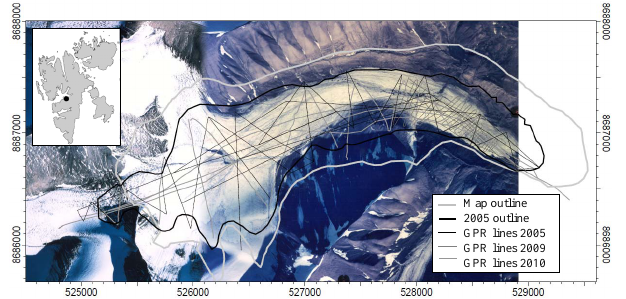
Fig. 1. Location of Tellbreen (inset) and 1995 aerial photo with map outlines, ca. 1938 (thick grey), 2005 outline (thick black) and GPR lines from 2004–05 (dark grey), 2009 (grey) and 2010 (lower third of the glacier, light